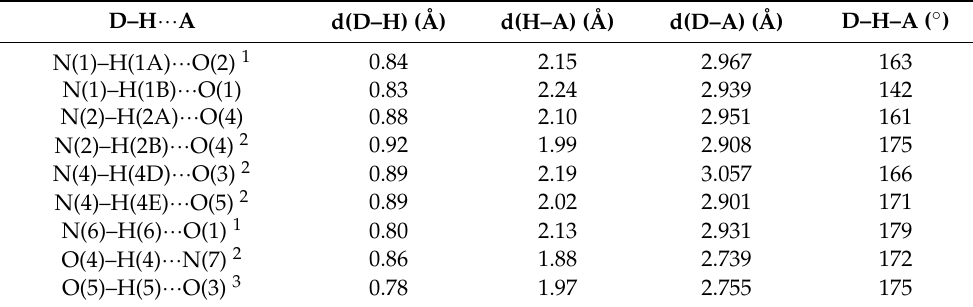
Table 2. Hydrogen bonds for Met–Bar.